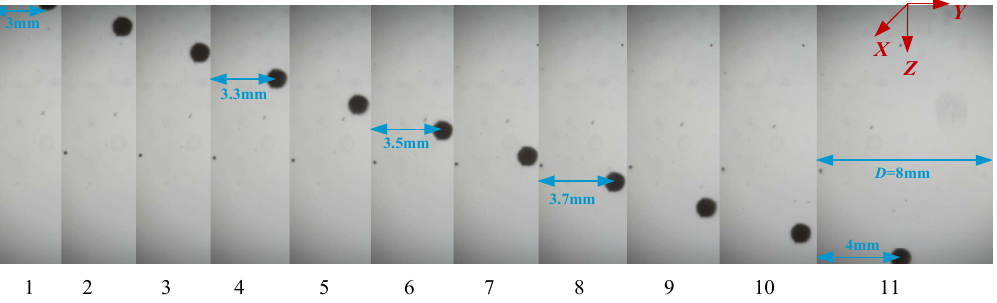
Figure 16. The process of a spherical copper particle from appearing in the sensor field of view to leaving.